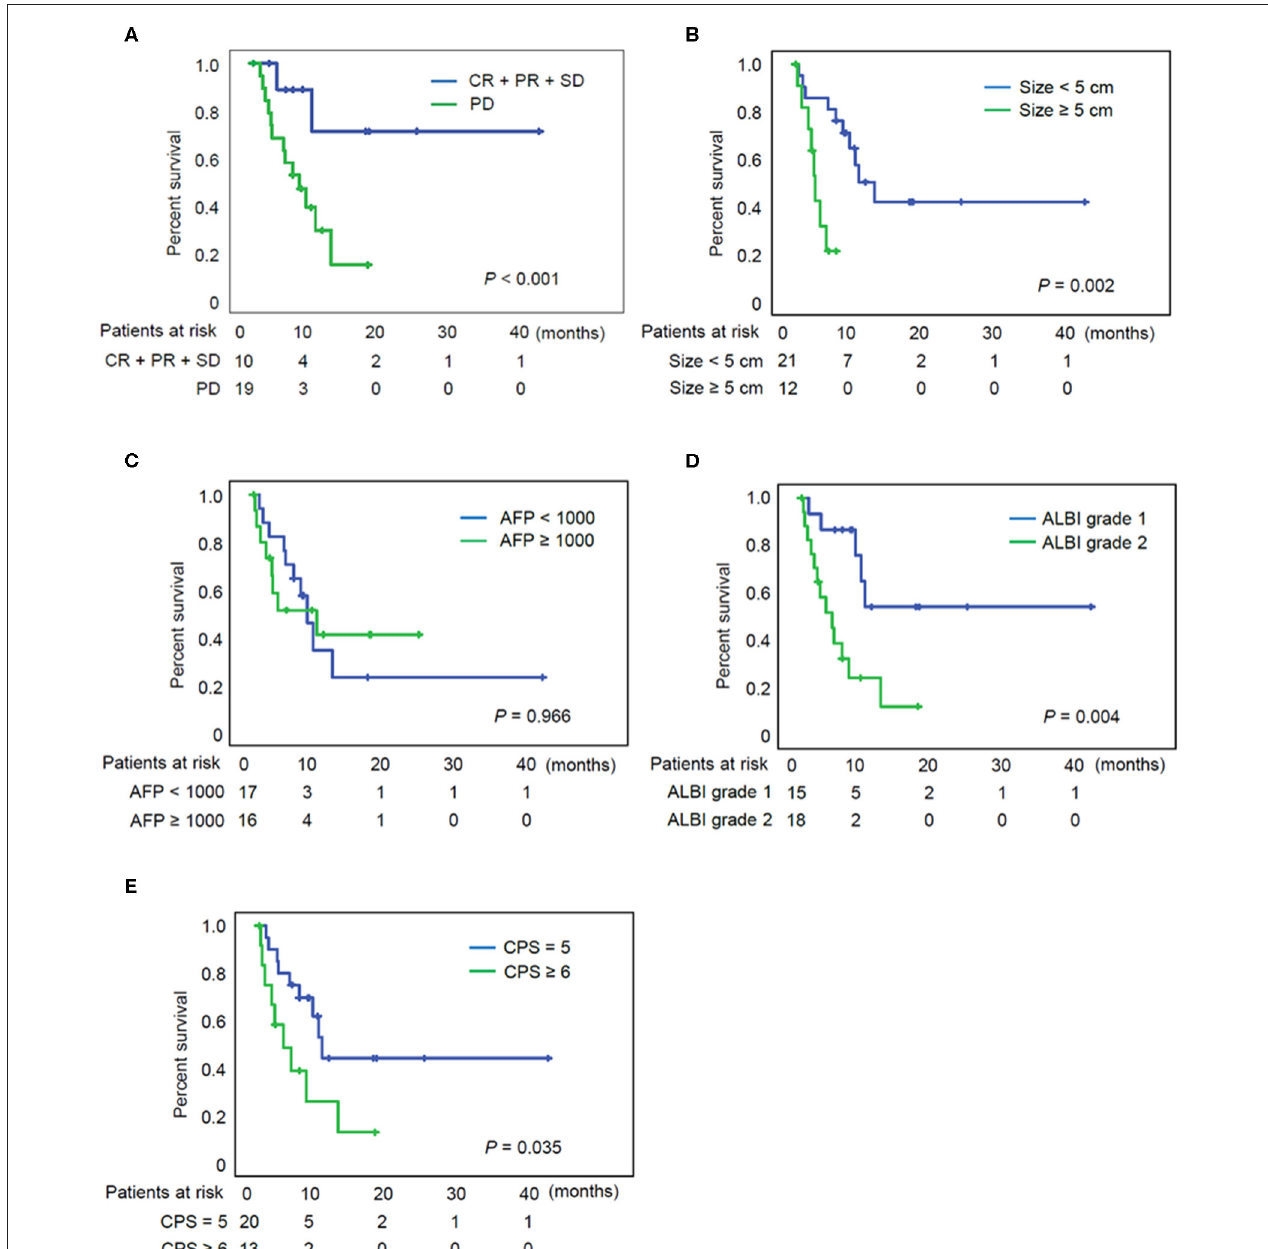
FIGURE 2 | Overall survival of patients according to the various clinical parameters. (A) Overall survival of patients according to the tumor response. (B) Overall survival of patients according to the tumor size. (C) Overall survival of patients according to the AFP. (D) Overall survival of patients according to the ALBI grade. (E) Overall survival of patients according to the CPS. AFP, alpha fetoprotein; ALBI grade, albumin-bilirubin grade; CPS, Child-Pugh score; CR, complete response; PD, progressive disease; PR, partial response; SD, stable